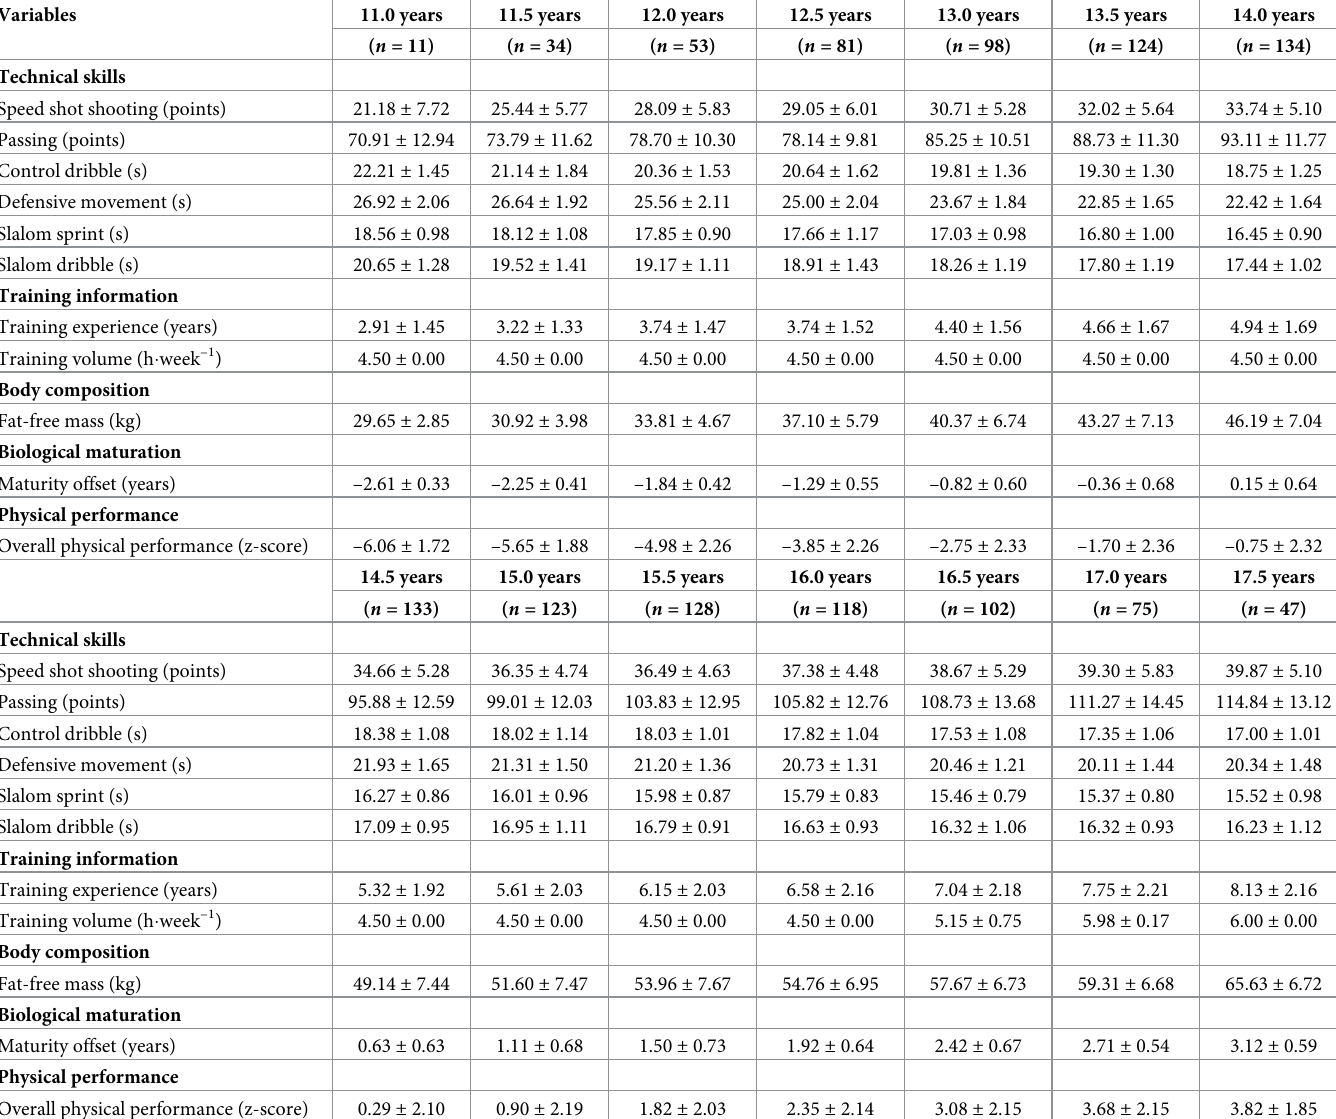
Table 2. Descriptive statistics (Mean ± SD) for all age